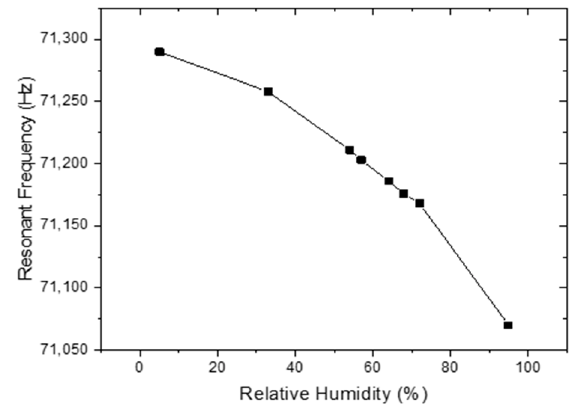
Figure 5. Variation of resonant frequency of MES-1 as a function of relative humidity levels.